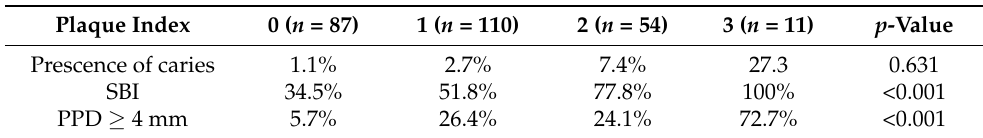
Table 2. Plaque index in relation to the presence of caries, Sulcus Bleeding Index (SBI) and probing pocket depth